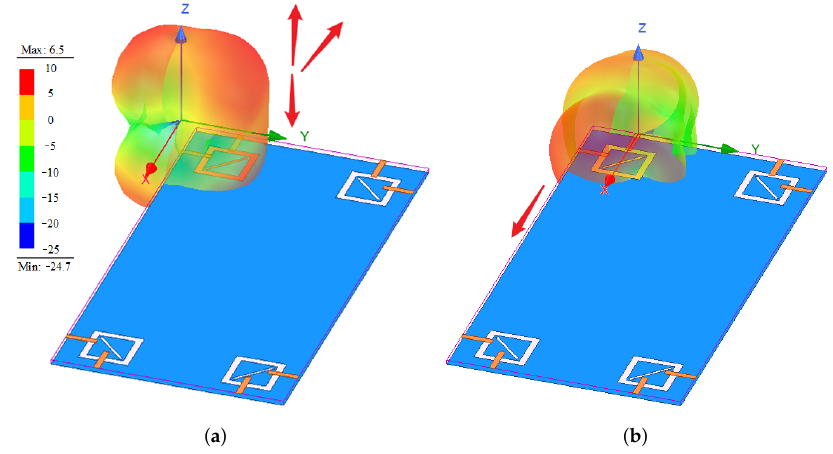
Figure 5. 3D radiation patterns of the proposed antenna at 3.5 GHz. ( a ) Port 1. ( b ) Port 2.